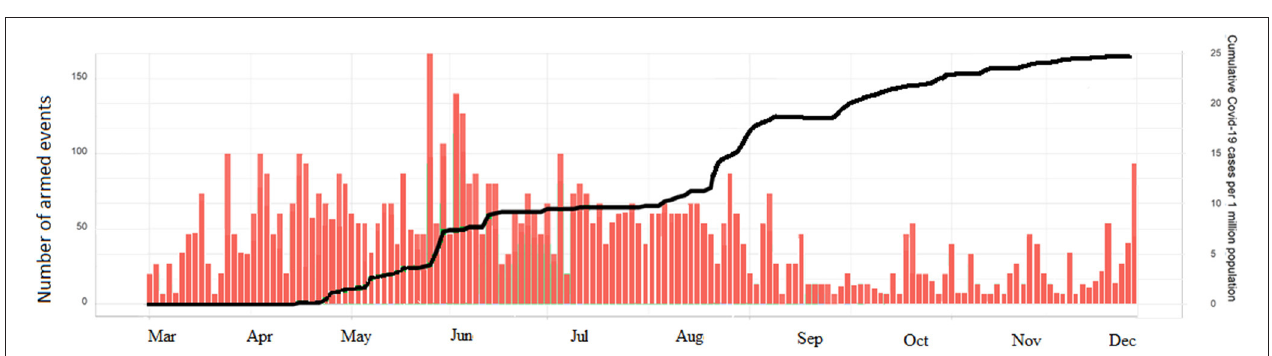
FIGURE 2 | Intensity of the armed conflict and patterns COVID-19 cases in Libya during the epidemic period (March until December 2020).